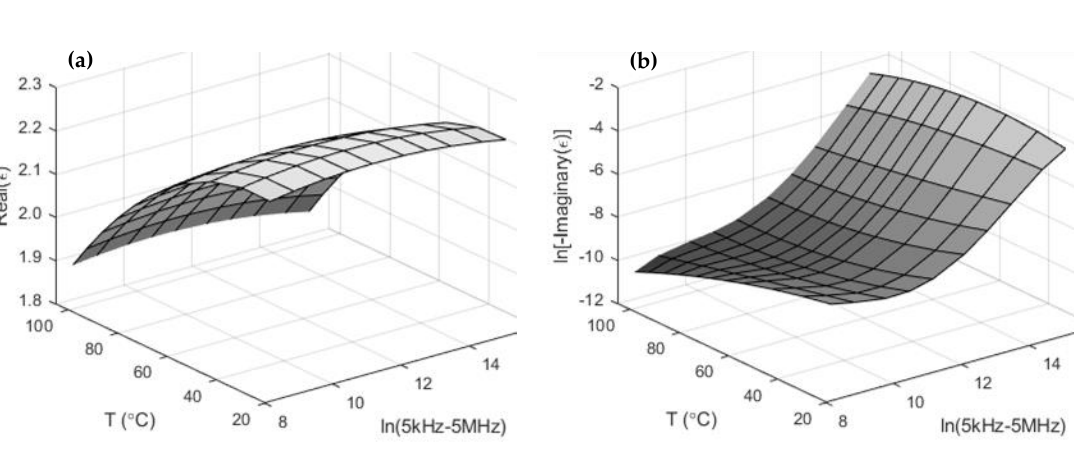
Figure 5. Polynomial fits for real relative permittivity ( a : 2 by 2 fit) and natural logarithm of imaginary relative permittivity ( b : 4 by 2 fit) as function of frequency ln( f ) and temperature T .